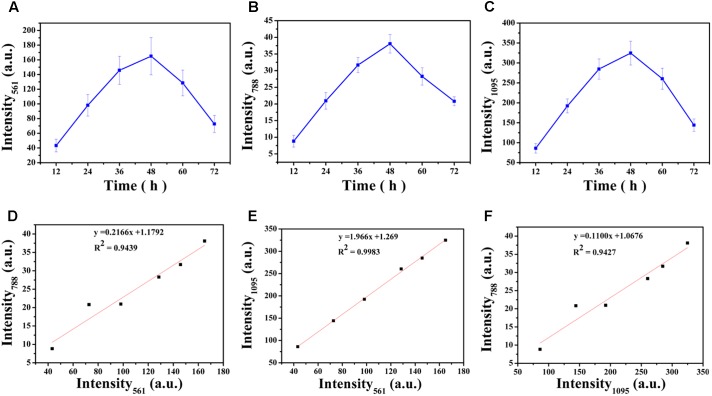
Variations in intensities of the corresponding Raman peaks over time (A–C): (A) 561 cm-1, (B) 788 cm-1, (C) 1,095 cm-1. Correlation between the intensities of Raman peaks (D–F): (D) Intensity561 and Intensity788, (E) Intensity561 and Intensity1095, (F) Intensity1095 and Intensity788. The error bar represents the standard deviation of five measurements. Intensity561, Intensity788, and Intensity1095 indicate the peak at 561 cm-1, 788 cm-1 and 1,095 cm-1, respectively.